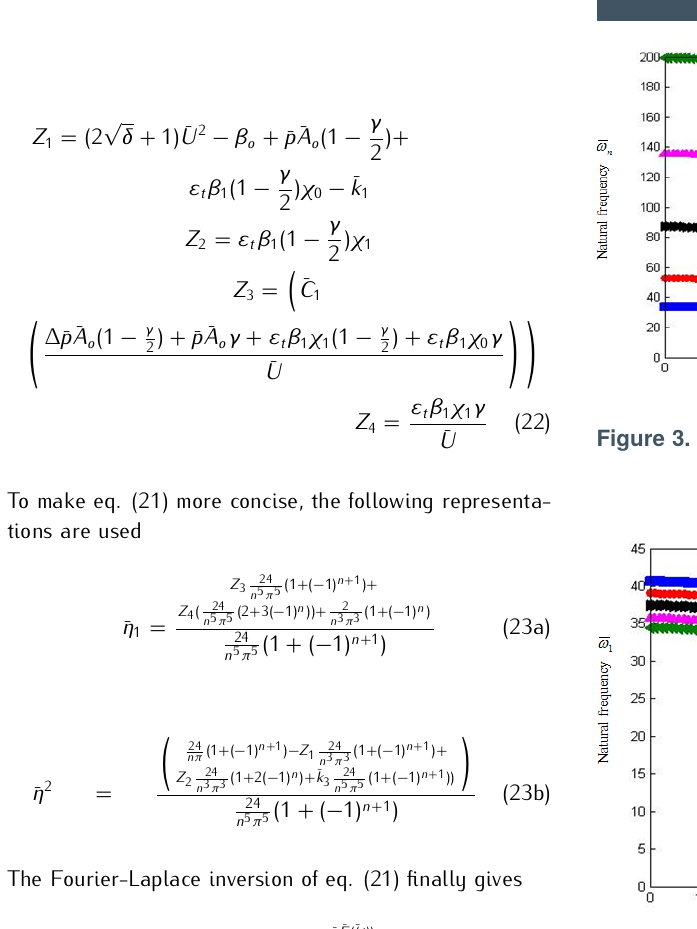
Figure 4. Absolute values of the transverse natural frequencies profile for the case R i = 0 . 41 m,L = 2 km,γ = 0 . 02 ,n = 1 ,δ 1 = 0 . 3721 ,χ = − 0 .